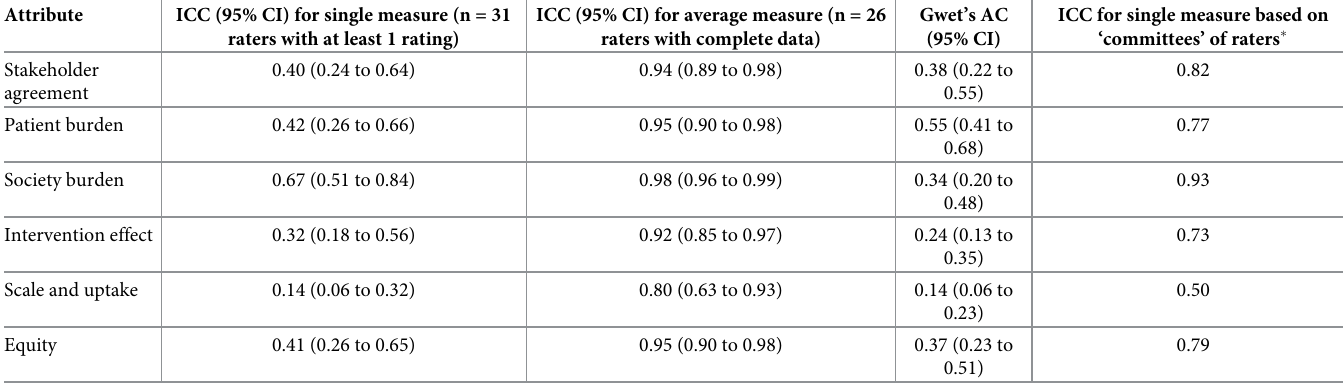
Table 3. Agreement coefficient and ICC for each attribute (2-way random-effects model, absolute agreement). Attribute